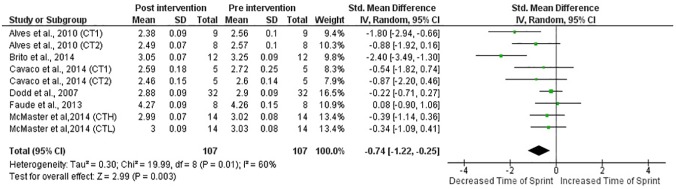
Standardized mean difference (SMD) between post and pre-intervention sprint time in CT-trained subjects.Squares represent the SMDa for each trial. Diamonds represent the pooled SMD across trials.